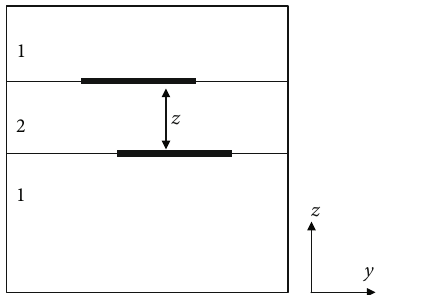
Figure 17: The distance relation model between fi bers.